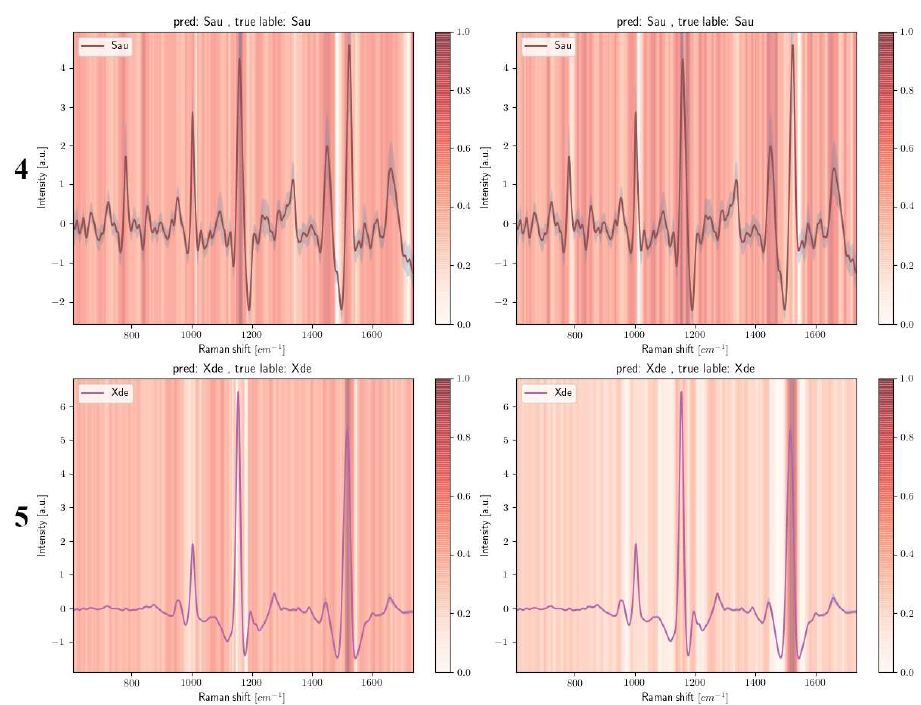
Figure 5. Mean Raman spectra of carotenoid-containing microorganisms Cin ( A1 ), Kro ( A2 ), Mlu ( A3 ), Sau ( A4 ), Xde ( A5 ) and normalized Grad-CAM indicator of CNN used signatures of model 1. Mean Raman spectra of carotenoid-containing microorganisms Cin ( B1 ), Kro ( B2 ), Mlu ( B3 ), Sau ( B4 ), Xde ( B5 ) and normalized Grad-CAM indicator of CNN used signatures of model 2. Z-score normalized Raman intensities on the Y -axis and Grad-CAM indicator normalized from zero to one (white to dark red).